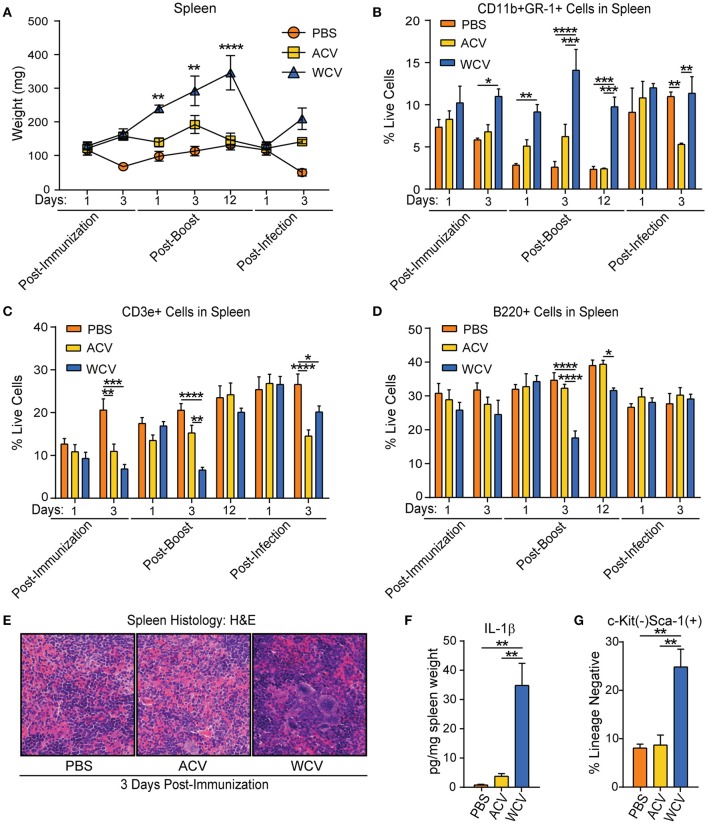
WCV content induces alterations in the size and composition of peripheral lymphoid organs suggesting extramedullary hematopoiesis may occur. (A) Spleen weights from CD-1 mice (n = 4/group for each time point) immunized with phosphate buffered saline (PBS), Bp acellular vaccine (ACV), or Bp whole cell vaccine (WCV) were recorded at the indicated time points across the immunization and infection schedule. (B) CD11b+Gr-1+ cell proportions in the spleen (n = 4/group for each time point) were measured by flow cytometric analysis. (C) CD3e+ cell proportions in the spleen (n = 4/group for each time point) were measured by flow cytometric analysis. (D) B220+ cell proportions in the spleen (n = 4/group for each time point) were measured by flow cytometric analysis. (E) Representative images were taken of H&E-stained spleen (n = 4/group) at 400X magnification. (F) IL-1β in spleen homogenate (n = 4/group) was measured by quantitative sandwich immunoassays. G. Proportions of lineage−c-kit−Sca-1+ cells in the spleen (n = 4/group for each time point) were measured using flow cytometric analysis. *p < 0.05; **p < 0.01; ***p < 0.001; ****p < 0.0001; 2-way ANOVAs with Tukey's multiple comparisons. Error bars are mean ± SEM values.